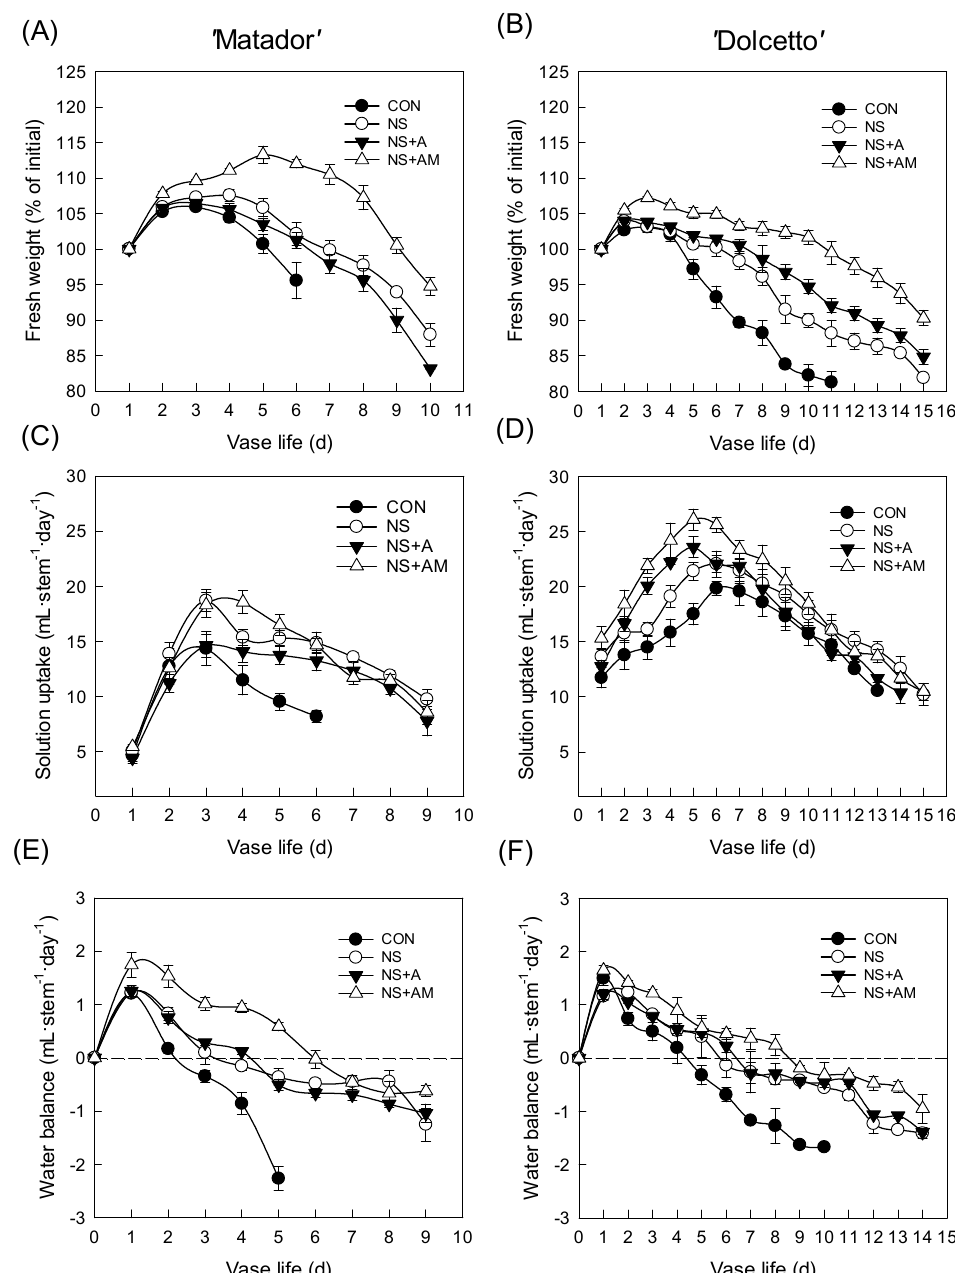
Figure 3. Changes in relative fresh weight, solution absorption, and water balance in ‘Matador’ ( A , C , E ) and ‘Dolcetto’ ( B , D , F ) cut roses. CON, control flowers were held in DW; NS, cut roses were treated with nano silver; NS+A, cut roses were treated with NS and AIB; NS+AM, cut roses were treated with NS, AIB, and 1-MCP. All cut roses were exposed to ethylene (2 µL L − 1 ) for 24 h at 25 ± 1 °C under dark conditions. Vertical bars show SE of the mean ( n = 6).